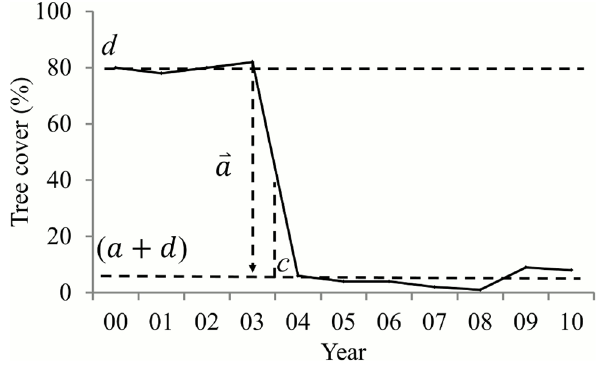
Fig 10. Structural parameters to characterize a deforestation